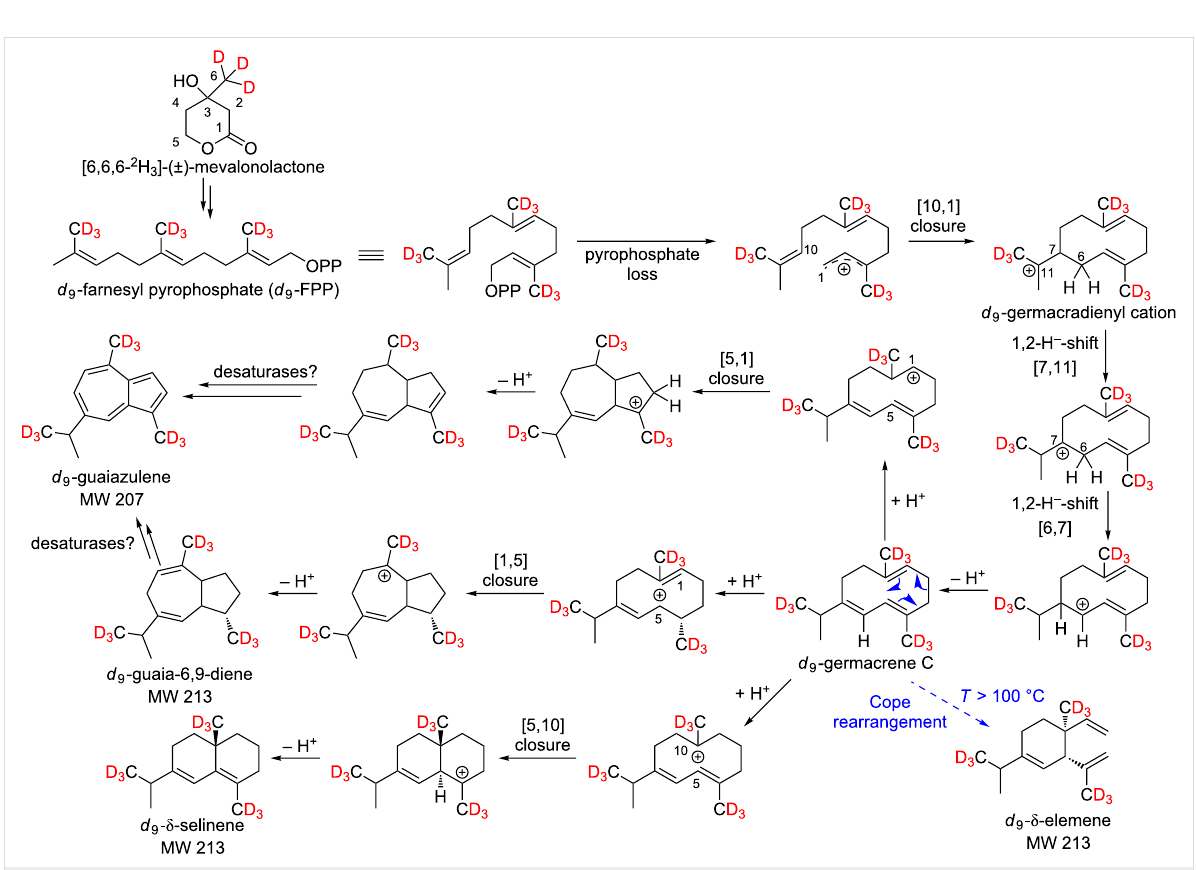
Figure 9: Mass spectra and associated structural formulas of d 0 - γ - elemene and d 9 - γ -elemene after administration of [6,6,6- 2 H 3 ]-(±)- mevalonolactone ( d 3 -MVL) to isolated exocarp of grape berries (Lemberger cultivar).